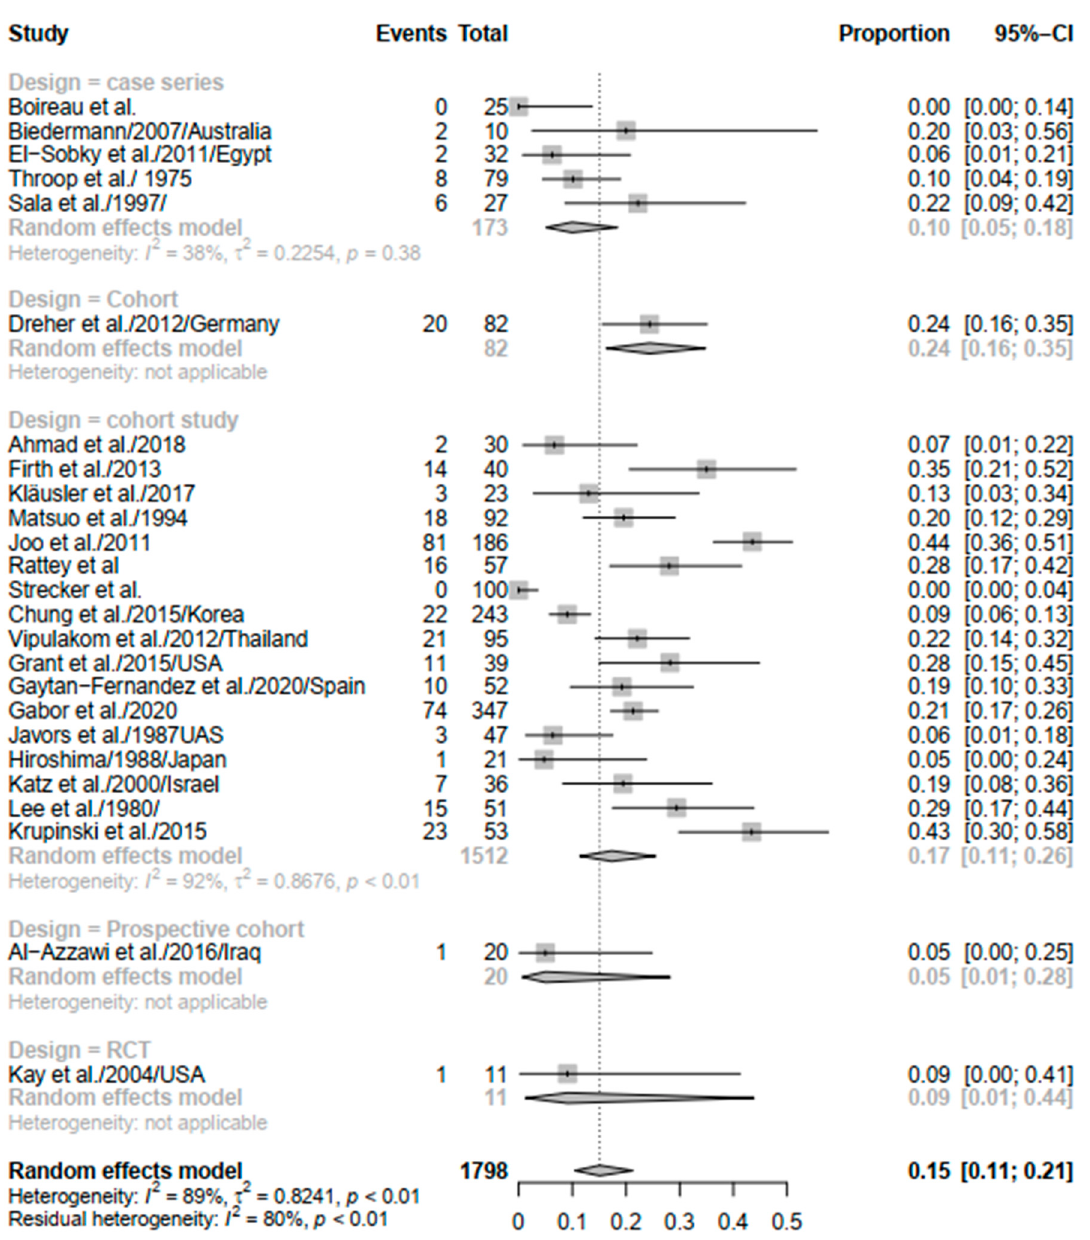
Figure 4. Forest plot of subgroup analysis of equinus recurrence based on study design.